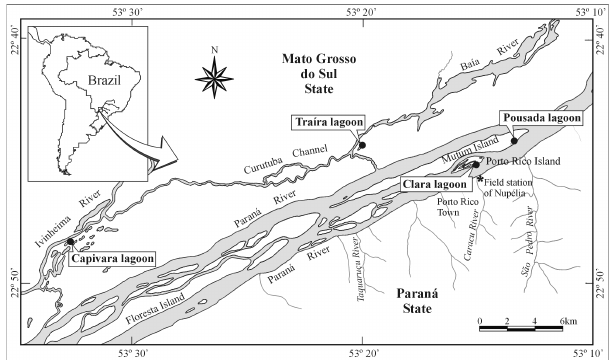
Fig. 1 . Map of the upper Paraná River floodplain showing the locations of the sampling stations